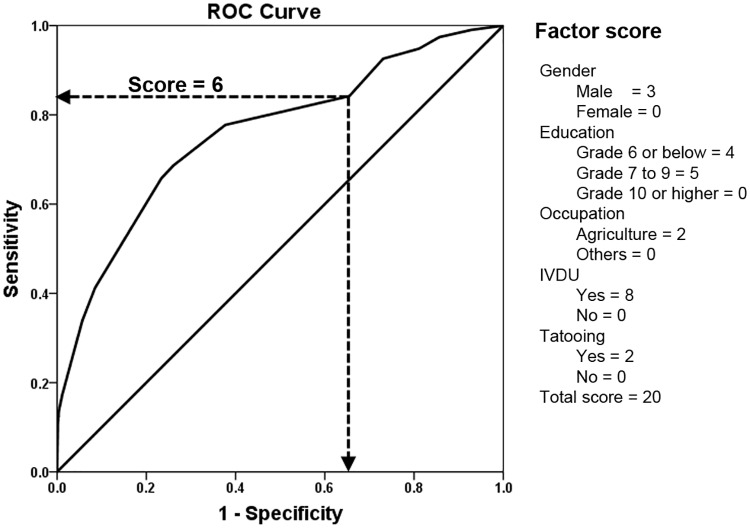
Receiving operating curve (ROC) of HCV screening score.The ROC represents an area under the curve (AUC) of HCV screening tool derived from factors associated with HCV infection. To maximize ascertainment of individuals with HCV, the cut-off score at 6 was chosen for the relatively high sensitivity at the expense of specificity.